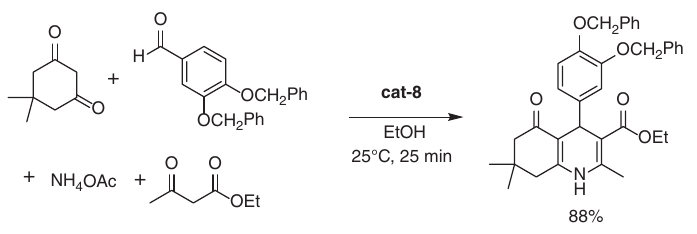
Scheme 18 The Hantzsch reaction promoted by